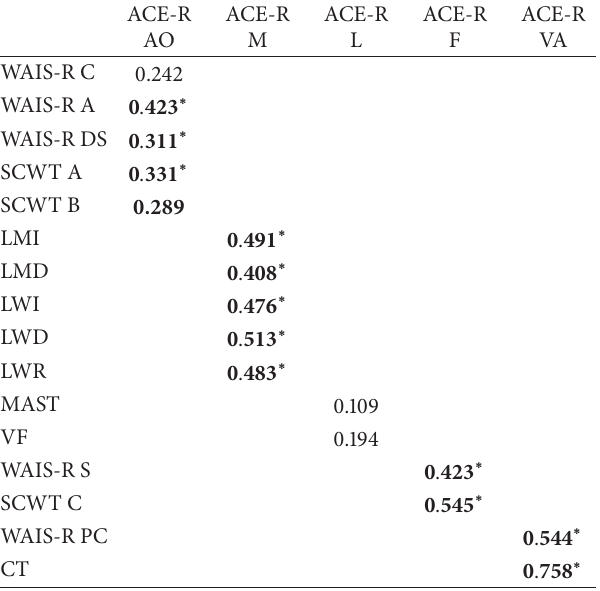
Table 3: Correlation coefficients between ACE-R subscores and relevant neuropsychological